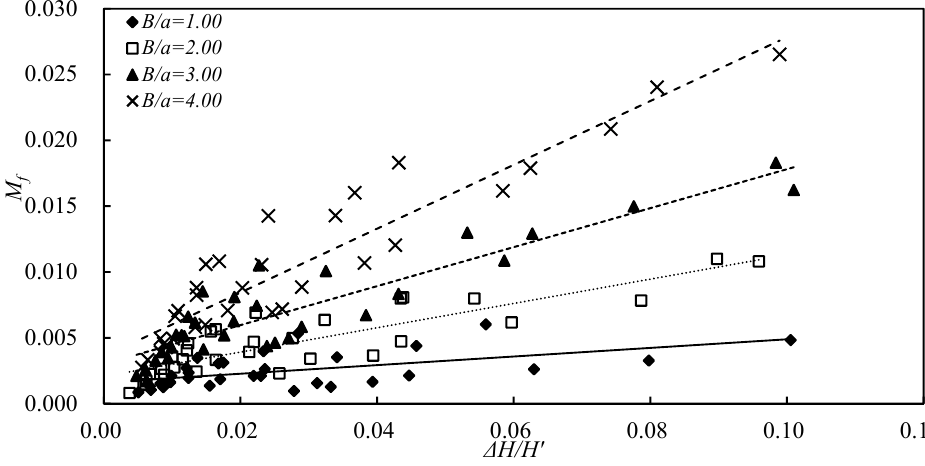
∆ H/H (cid:48) f and